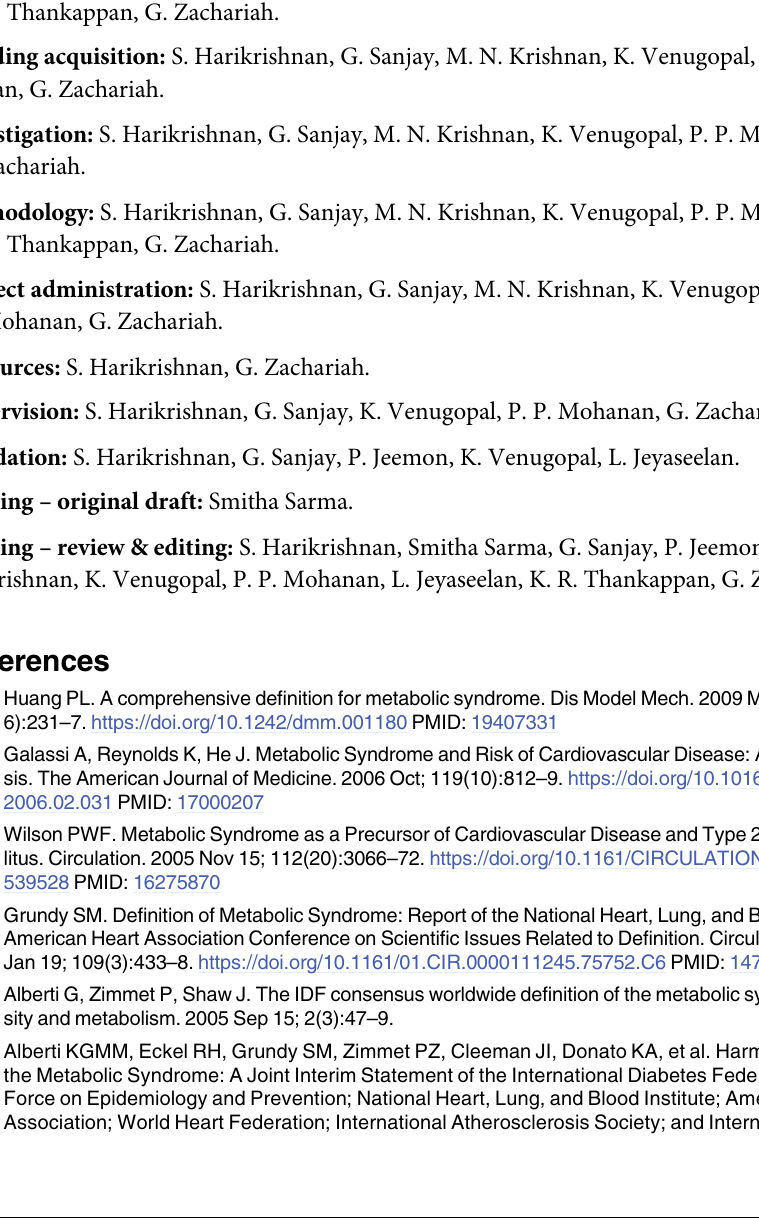
S2 Table. Physical activity and diet characterization of participants. Prevalence estimates have been standardized for age and adjusted for sex and urban-rural distribution (% and 95% confidence